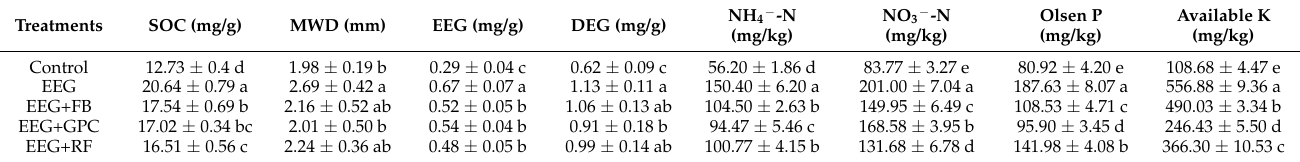
Table 3. Effects of foliar spraying easily extractable glomalin-related soil protein in combination with agronomic strategies on soil fertility and structure in Satsuma mandarin “Oita 4” trees. Treatments